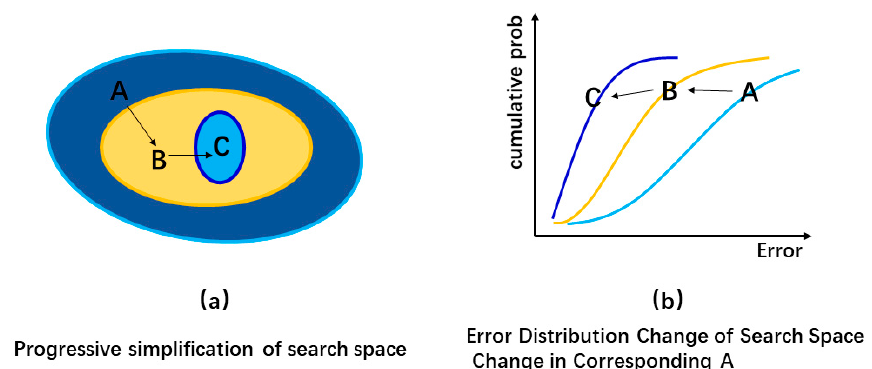
space. Each stage was composed of d i identical blocks (as shown in Figure 7c).